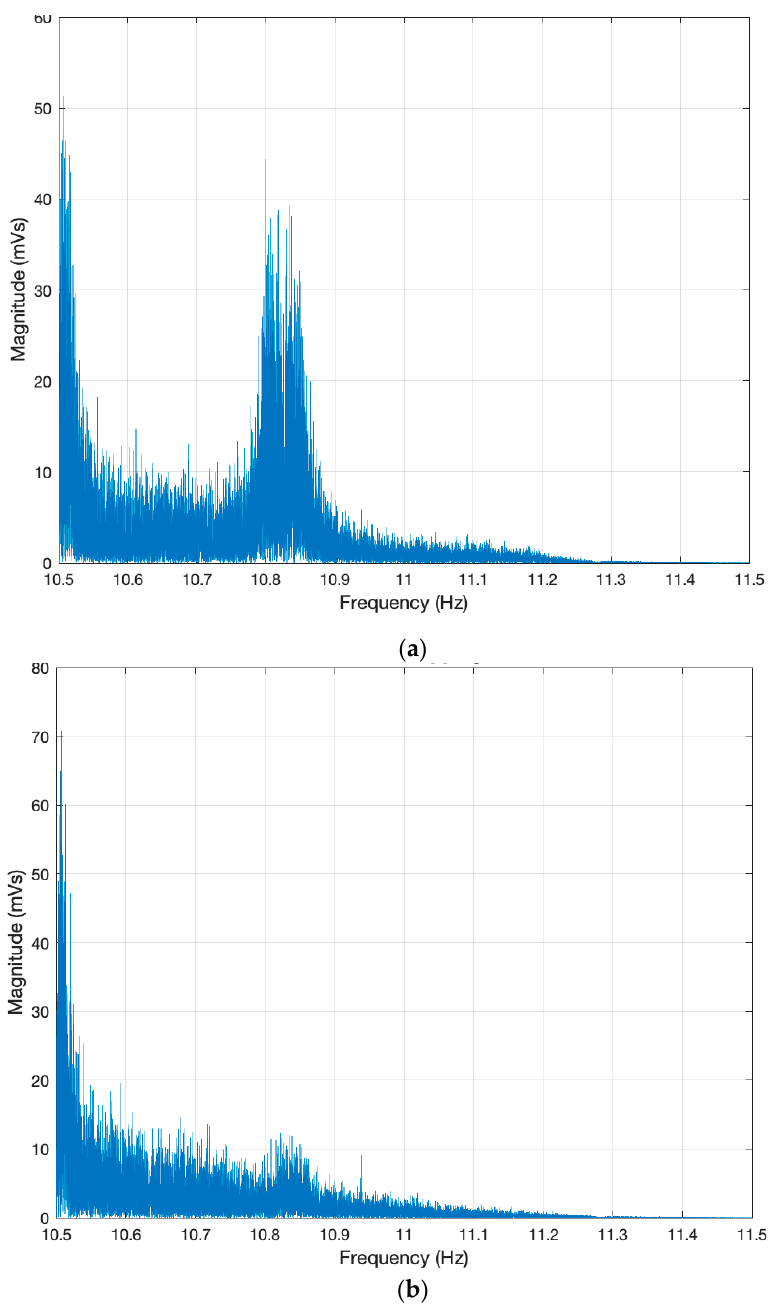
Figure 11. ( a ) Electroencephalographic (EEG) signal frequency spectrum of a drowsy subject (alpha wave at 10.8–10.9 Hz); ( b ) EEG signal frequency spectrum of a wakeful subject (beta wave: there is no specific frequency peak).